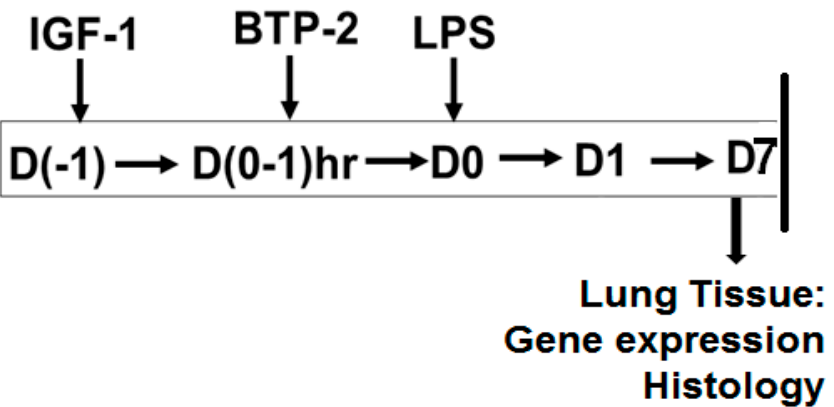
Figure 1. Schematic representation of the experimental setup used for the ALI studies.